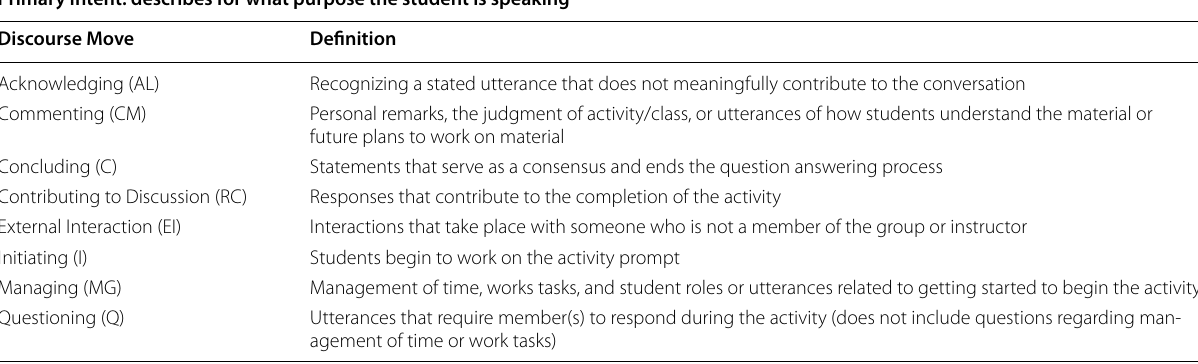
Table 2 Definitions of student interaction discourse moves primary intent codes. Abbreviations of each discourse move are in parenthesis next to the name of the